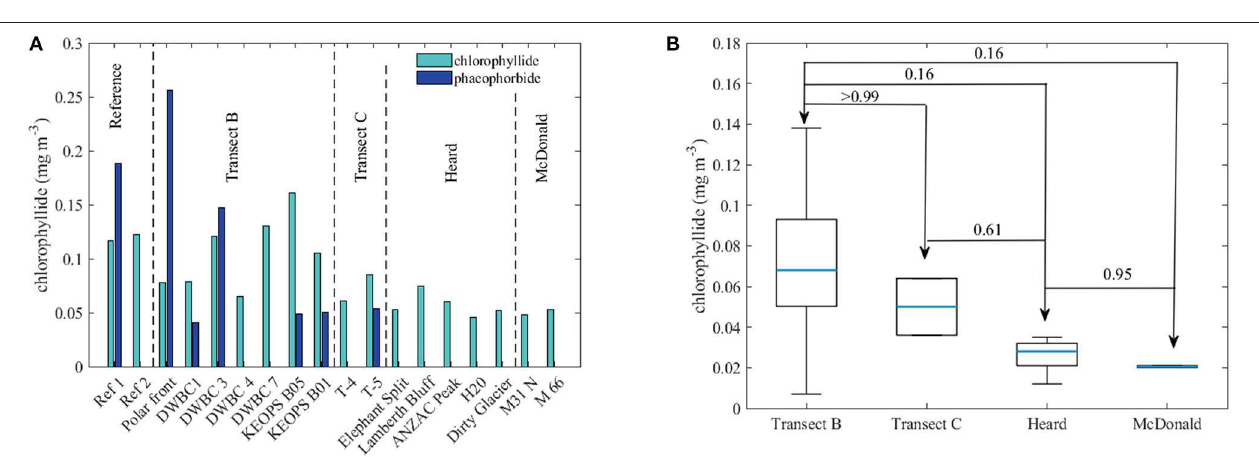
FIGURE 8 | (A) Ratios of concentrations of degradation products of chlorophyll a (phaeophorbide and chlorophyllide) and total chlorophyll a concentration (chl- a ) at all measurements stations, (B) average concentration of chlorophyllide in samples from reference, transect B and C, Heard and McDonald stations. All data presented in this figure are non-size-fractionated (total) concentrations. In the boxplot (B) the blue lines indicate the median and the box represents the range between 25 and 75% quartile and the whiskers correspond to ± 2.7 standard deviation (99.3% of data if normally distributed). The numbers given are the p -values for the Kruskal-Wallis test.